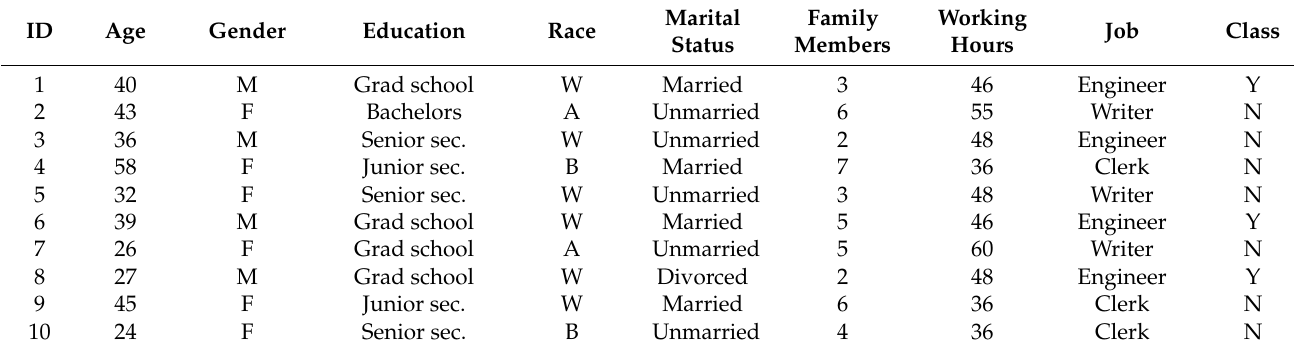
Table 2. High-dimensional raw data.